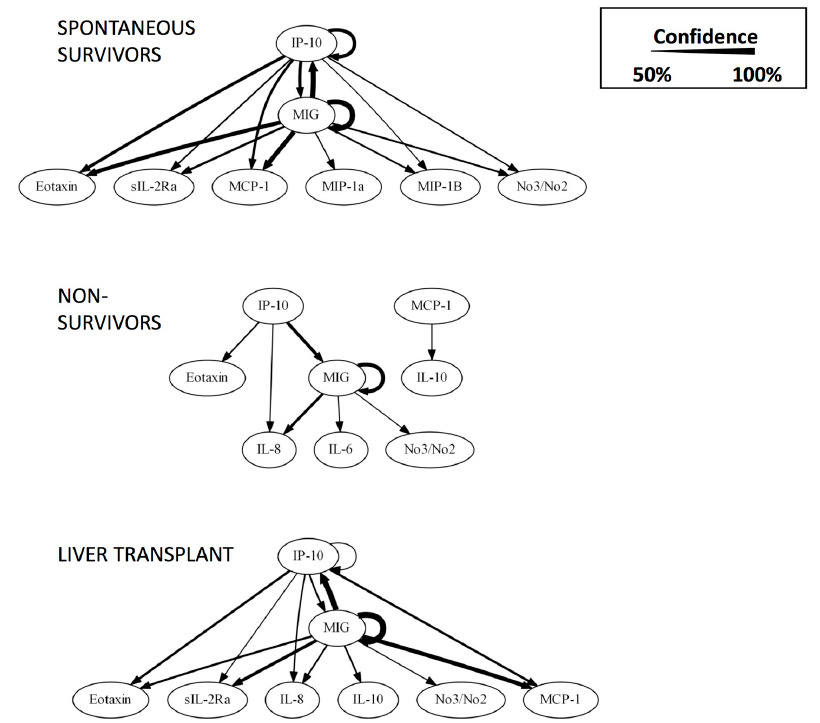
Figure 6. Pediatric acute liver failure (PALF) outcome group DyBN: When performed on each patient group (spontaneous survivors, non-survivors, transplant recipients), DyBN reveals two distinct pathways: one leading to negative feedback-induced resolvable inflammation, and the other to unresolvable inflammation caused by an unchecked positive feedback loop. The network representing patients who went on to receive liver transplants is quite similar to that of spontaneously surviving patients.